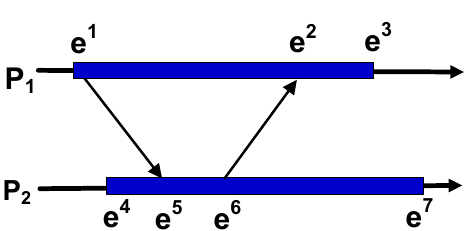
Figure 2. Temporal relations based on different kinds of clocks. P 1 and P 2 are devices, each of which is represented by a time axis oriented from the left to right. e 1 , e 2 ... are events that happened in devices at different timestamps. An arrow from one event to another represents a message transfer. According to the physical clock, the sequence of events can be directly determined by their timestamps (e.g., e 3 is before e 7 ). According to the logical clock, the sequence of events is determined by message passing (e.g., e 1 is before e 5 ) or local timestamps (e.g., e 1 is before e 2